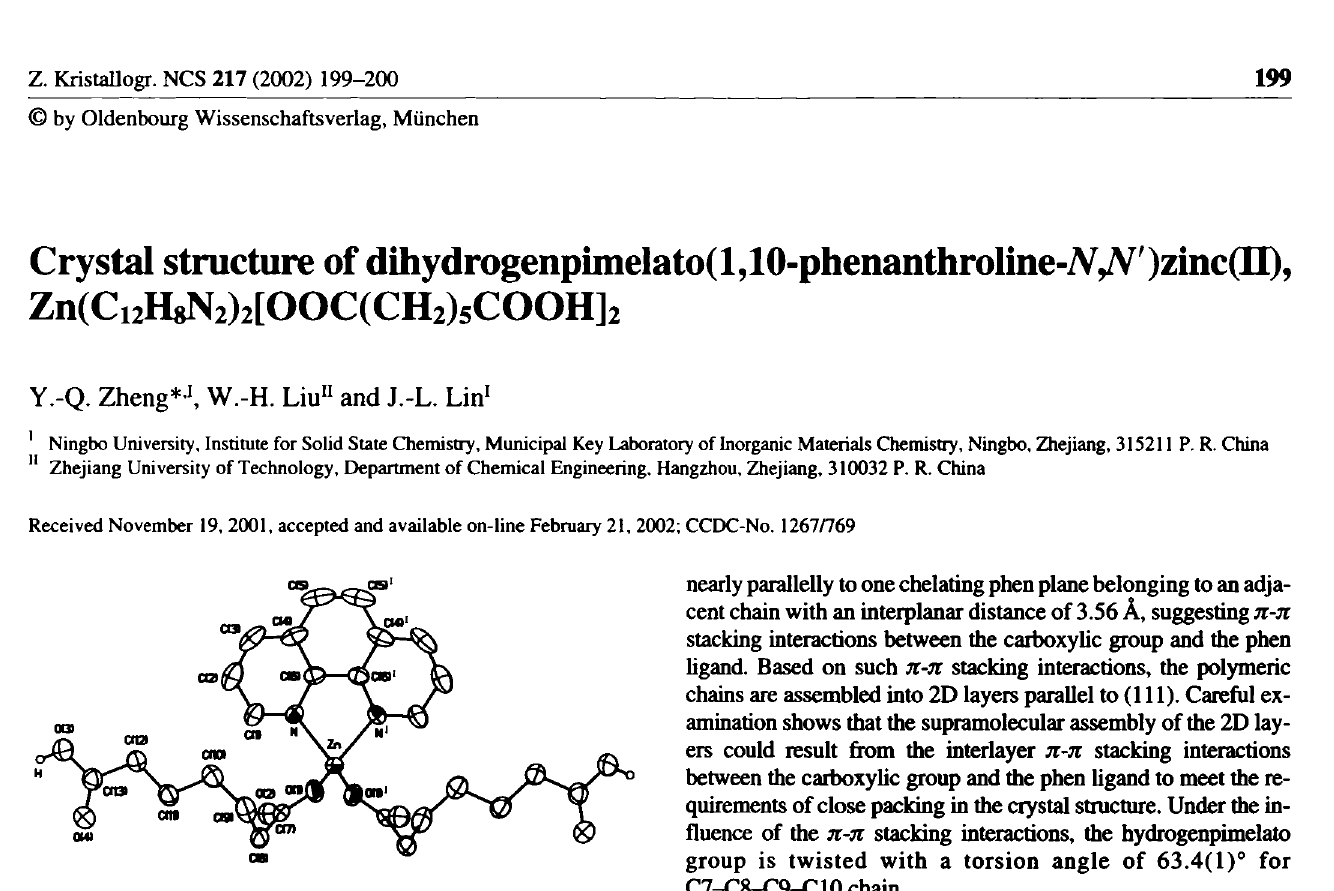
Table 1. Data collection and handling.